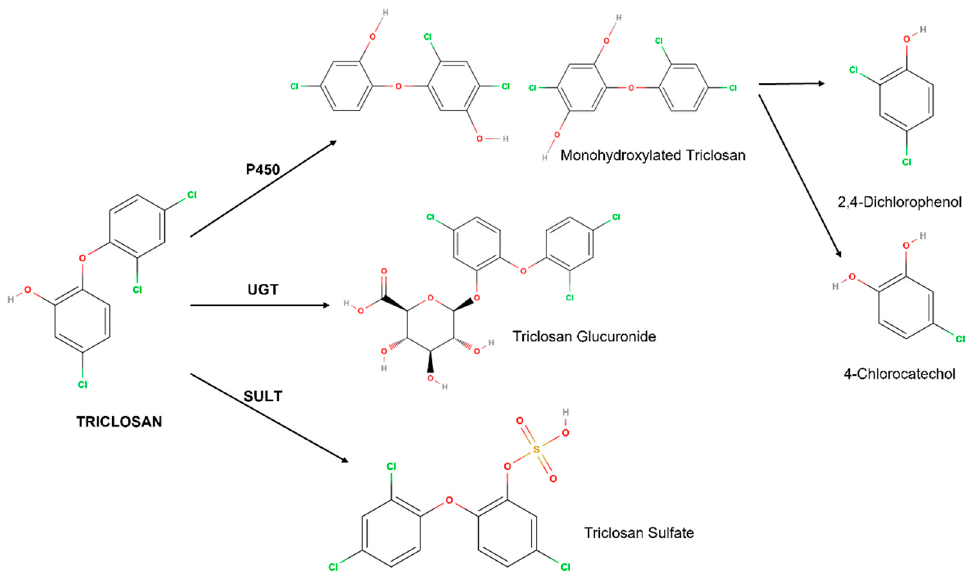
Figure 1. Metabolism of triclosan and its metabolites.